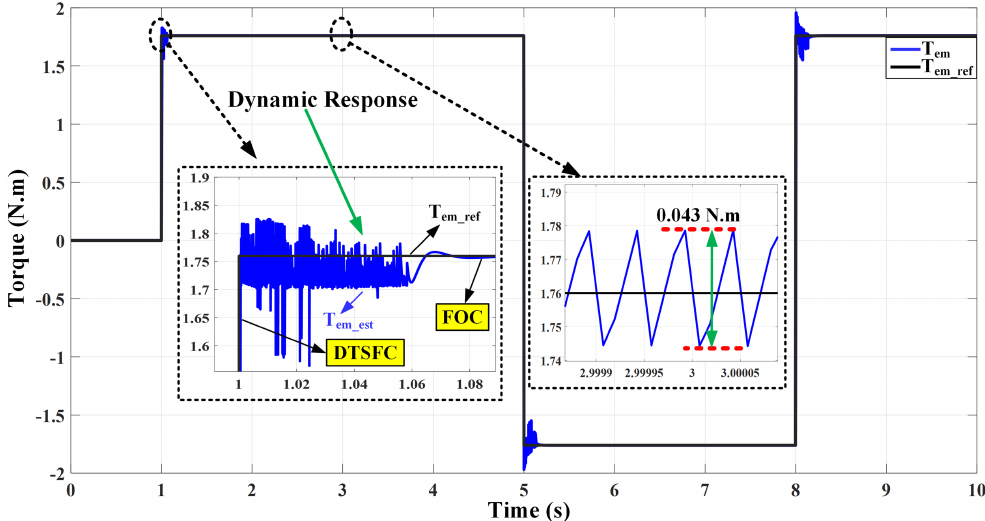
Figure 21. Electromagnetic torque response of the proposed combined FOC-DTC algorithms.